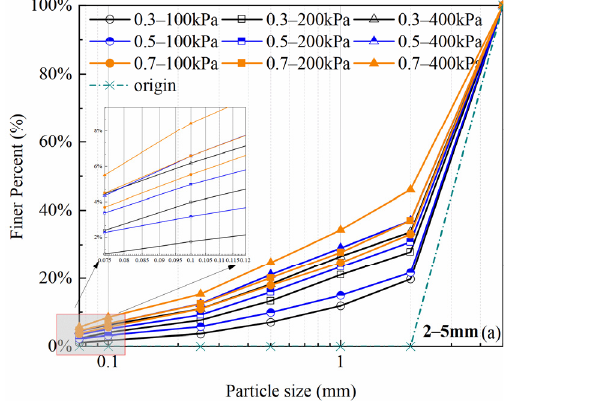
Figure 13. Evolutions of particle size distribution curves of volcanic soil with different relative density ( Dr ) and confining pressure( σ 3 ): ( a ) 2–5 mm particle groups; ( b ) 0.5–2 mm particle groups.